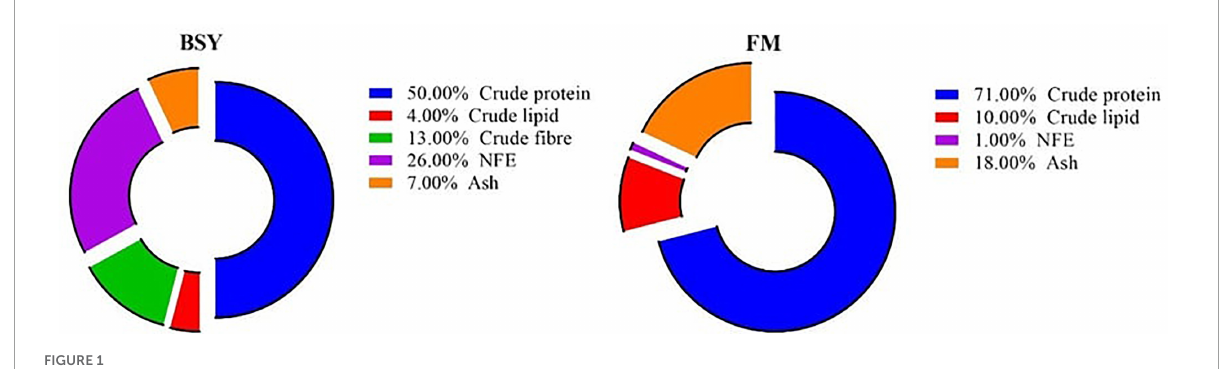
FIGURE1 Chemical composition of fishmeal (FM) and brewer’s spent yeast